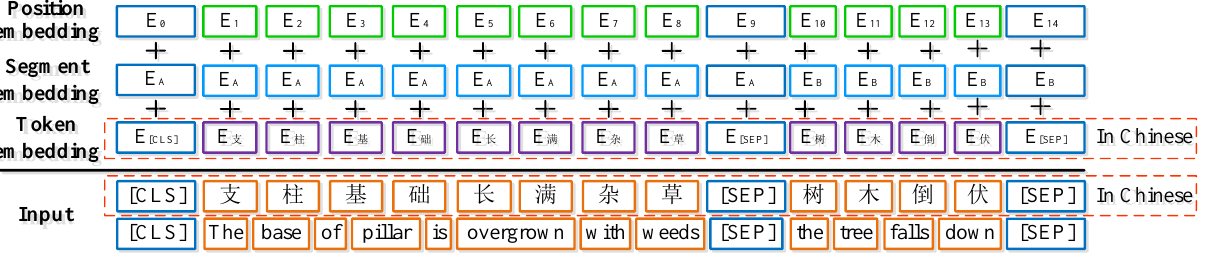
Figure 6. An example of the BERT input